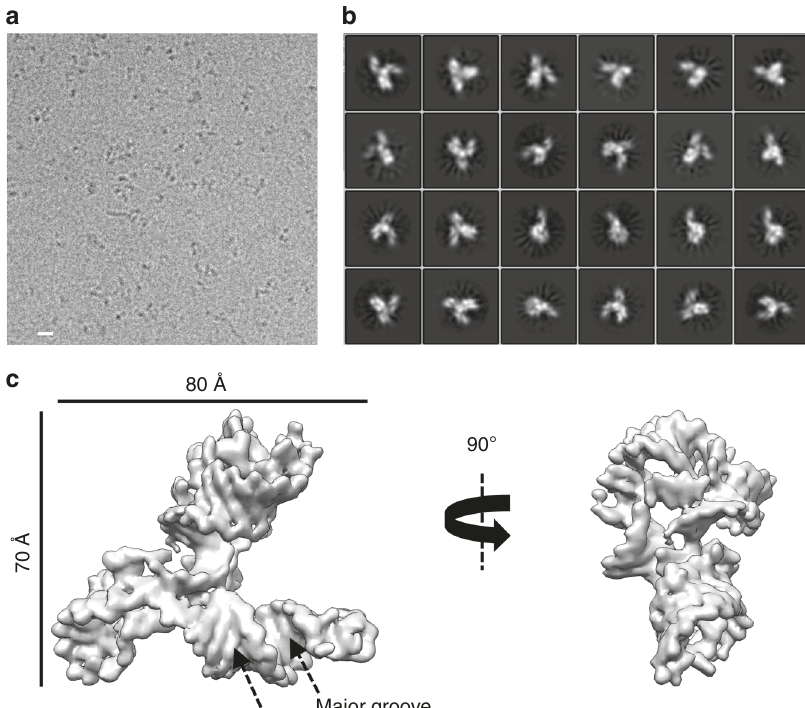
Fig. 1 Single-particle cryo-EM analysis of the apo SAM-IV riboswitch collected on Titan Krios. a Representative motion-corrected cryo-EM micrograph. Scale bar represents 100 Å. b Reference-free 2D class averages computed in Relion. c Final 3D reconstruction in two different views.